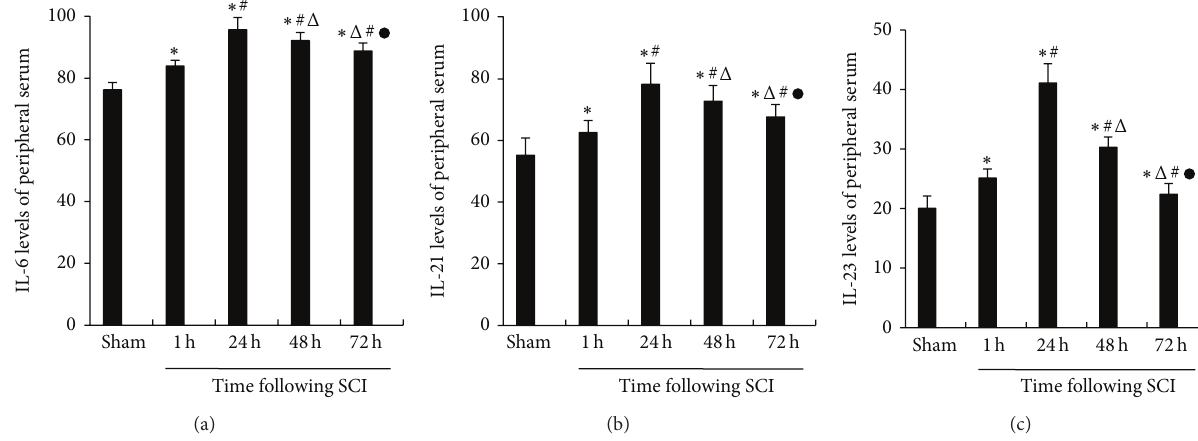
Figure 6: The IL-6, IL-21, and IL-23 levels of peripheral serum. The levels in the IL-6, IL-21, and IL-23 in the different groups, measured by ELISA. The IL-6 levels were 76.18 ± 2.36 , 83.93 ± 1.85 , 95.65 ± 3.97 , 92.10 ± 2.64 , and 88.81 ± 2.58 . The IL-21 levels were 55.22 ± 5.59 , 62.58 ± 3.91 , 78.25 ± 6.82 , 72.73 ± 5.18 , and 67.65 ± 4.02 . The IL-23 levels were 20.05 ± 2.07 , 25.15 ± 1.51 , 41.12 ± 3.19 , 30.33 ± 1.69 , and 22.42 ± 1.78 , respectively, in the sham-operated group ( 𝑛 = 15 ), 1h group of SCI ( 𝑛 = 15 ), 24 h group of SCI ( 𝑛 = 15 ), 48 h group of SCI ( 𝑛 = 15 ), and 72 h ( 𝑛 = 15 ) group of SCI. The data are presented as the mean ± the SE. ∗ 𝑃 < 0.05 versus sham, # 𝑃 < 0.05 versus 1h, △ 𝑃 < 0.05 versus 24 h, and e 𝑃 < 0.05 versus 48